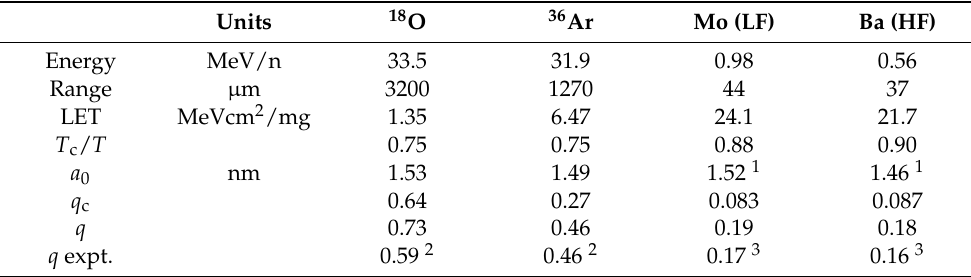
Table 1. Quenching factors calculated for 18 O, 36 Ar, Mo and Ba ions in liquid argon. Mo and Ba ions are for 252 Cf light fragments (LFs) and heavy fragments (HFs),